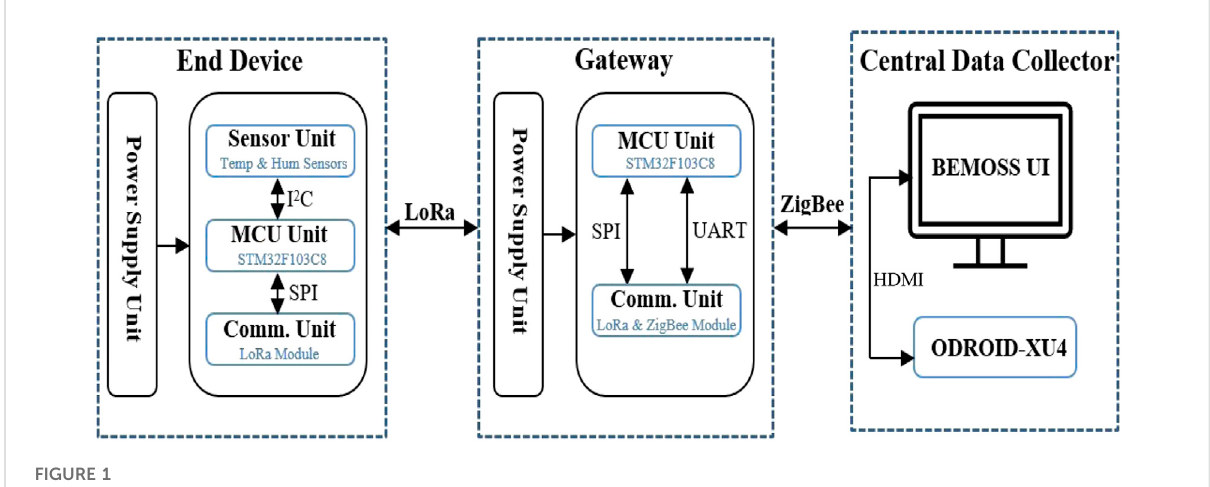
FIGURE 1 Block diagram of the